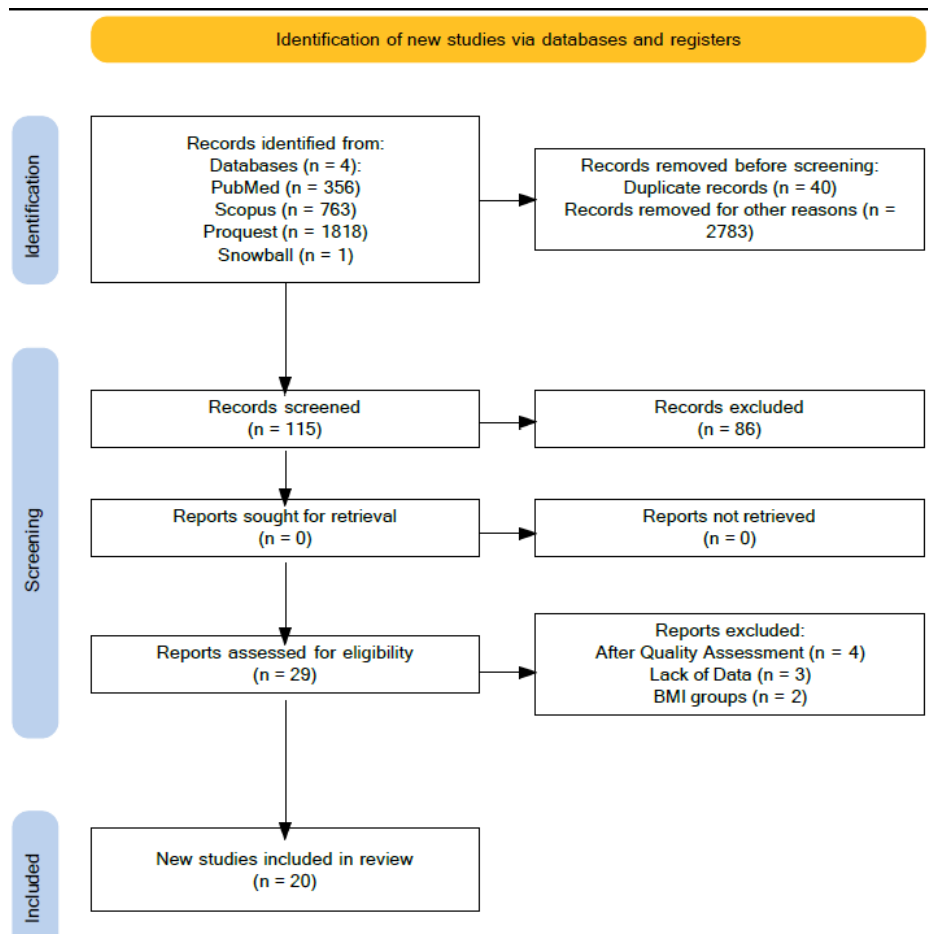
Figure 1. PRISMA flow diagram of the selection process.